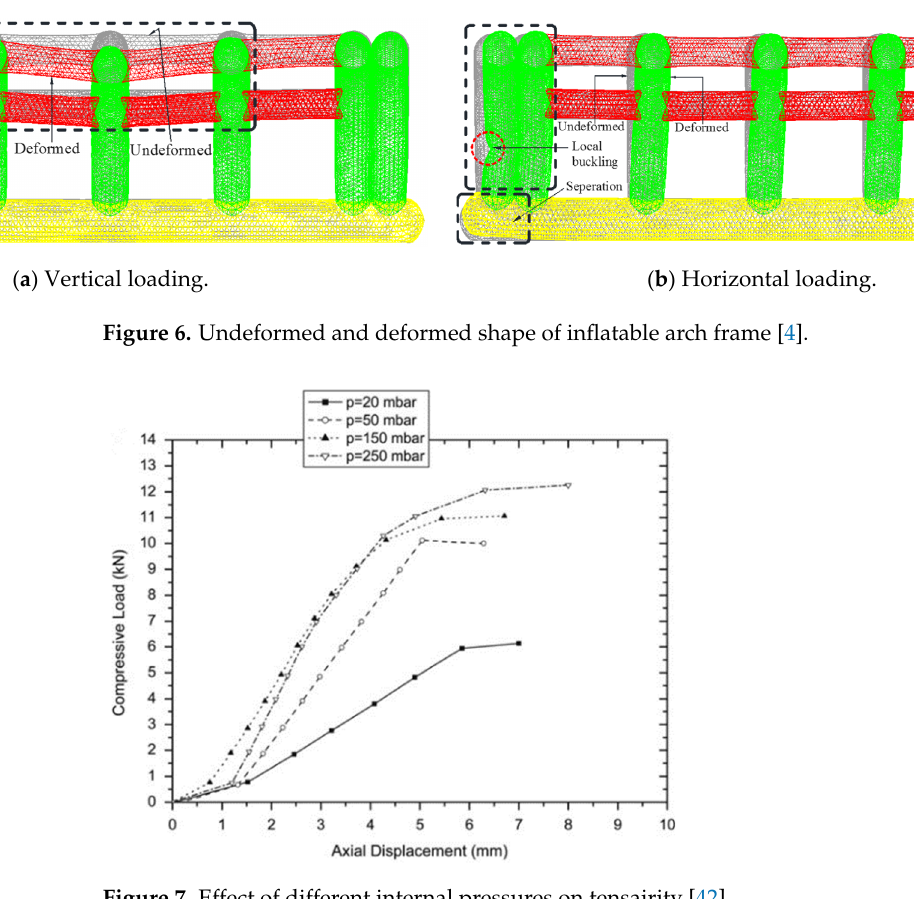
Figure 7. Effect of different internal pressures on tensairity [42].